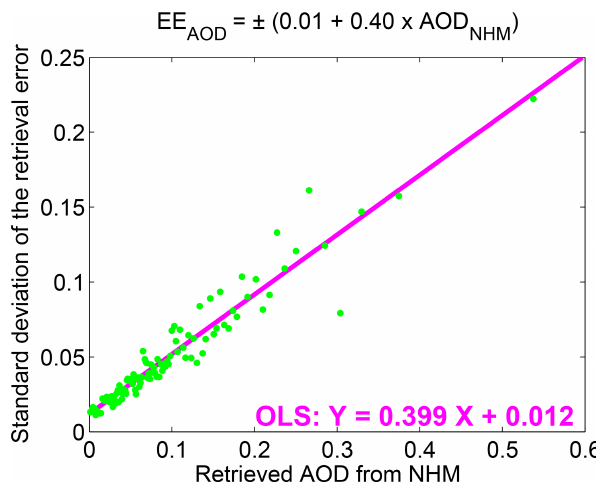
Figure 7. Scatterplot showing the standard deviations of the re- trieval error as a function of the average of retrieved AOD in each bin. The magenta line represents the fitted uncertainty